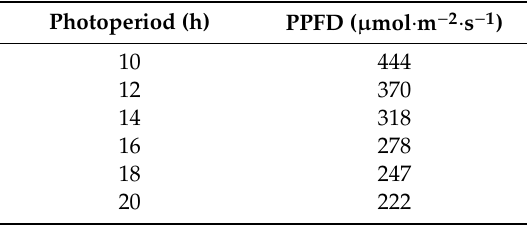
Table 1. The six lighting treatments with di ff erent photoperiods and photosynthetic photon flux density (PPFD). The PPFD decreased proportionally as the photoperiod increased to maintain a daily light integral (DLI) of 16 mol · m − 2 · d − 1 in all